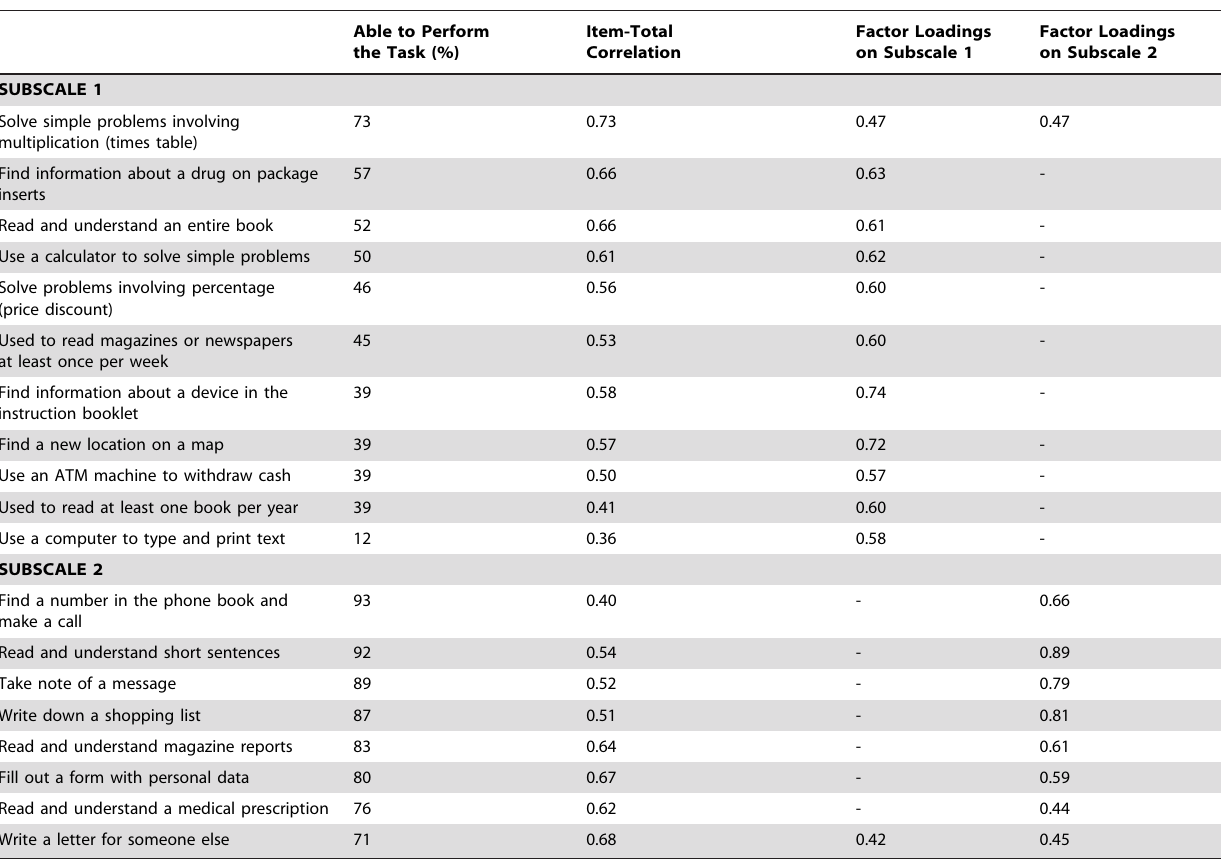
Table 1. Classical test theory and principal component analysis